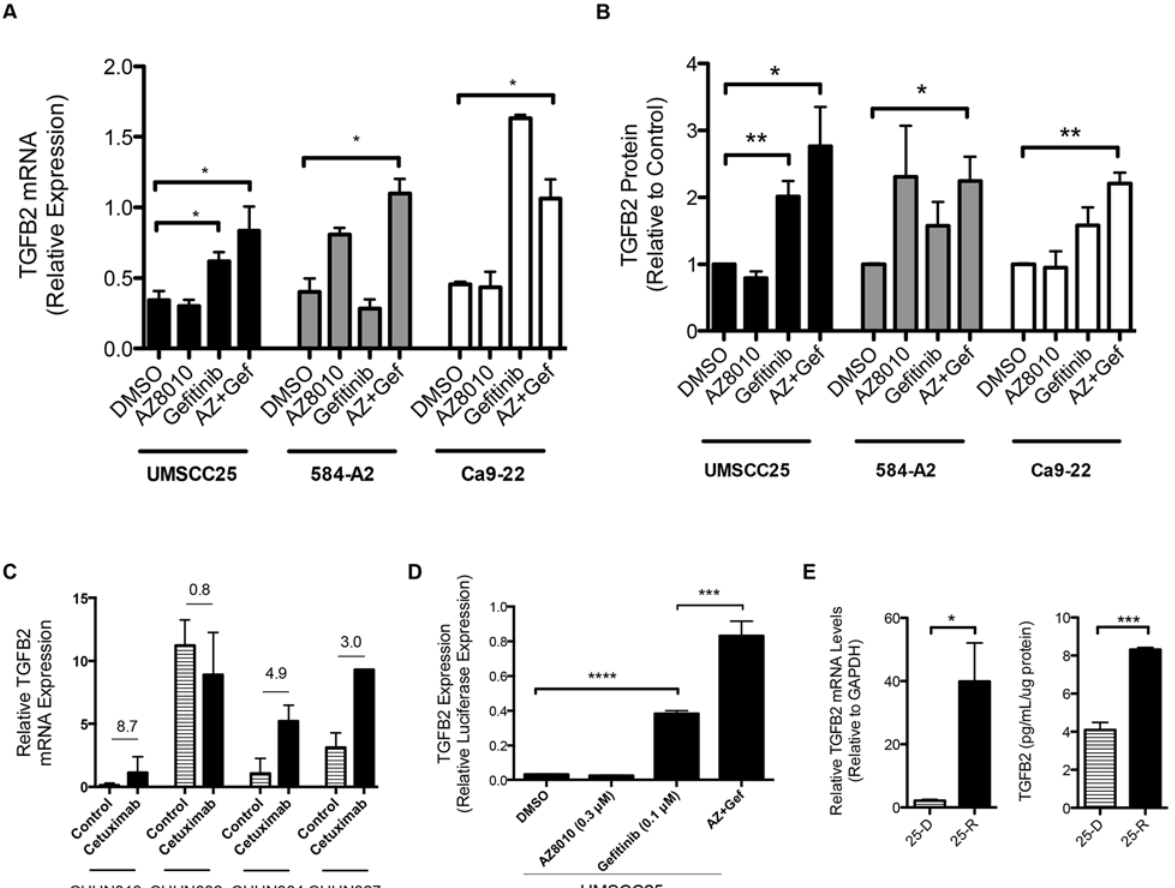
Fig 2. TGF- β 2 is induced in response to treatment with EGFR and FGFR TKIs. A. qRT-PCR was performed to verify that TGF-2 mRNA was upregulated after TKI treatment in the cell lines used for the gene chip (UMSCC25, 584-A2, Ca9-22). * denotes a p-value < 0.05. B. An ELISA was performed on the media from the cell lines and revealed an increase in TGF-2 protein secreted from cells upon treatment with TKIs. C. Patient-derived xenograft tumors were treated for 4 weeks with vehicle control or cetuximab, after which RNA was isolated from the tumors and qRT-PCR was performed to assess TGF- β 2 mRNA levels. The values indicate the fold change between the treated and control tumors. D. A TGF- β 2 promoter firefly luciferase construct was used to measure changes in TGF- β 2 transcription in UMSCC25 cells in response to EGFR and FGFR TKIs. This experiment is a representative of 3 others. In all experiments, cells were treated for 4 days with DMSO, 0.1 μ M gefitinib, 0.3 μ M AZD8010, or AZD8010 and gefitinib. E. UMSCC25 cells were adapted to increasing concentrations of gefitinib (up to 3 μ M) over the course of 3 months. RNA was isolated and qRT-PCR was performed to determine the mRNA levels of TGF- β 2. An increase in TGF- β 2 mRNA is observed in the chronically adapted cells (25-R) versus the control cells (25-D). Data are the average of the percent of control of 3 independent RNA samples. An ELISA shows that the concentration of TGF- β 2 in the media of 25-R cells is greater than the concentration in the media from control cells. * denotes a p-value < 0.025; ** denotes a p-value < 0.007; *** denotes a p-value <